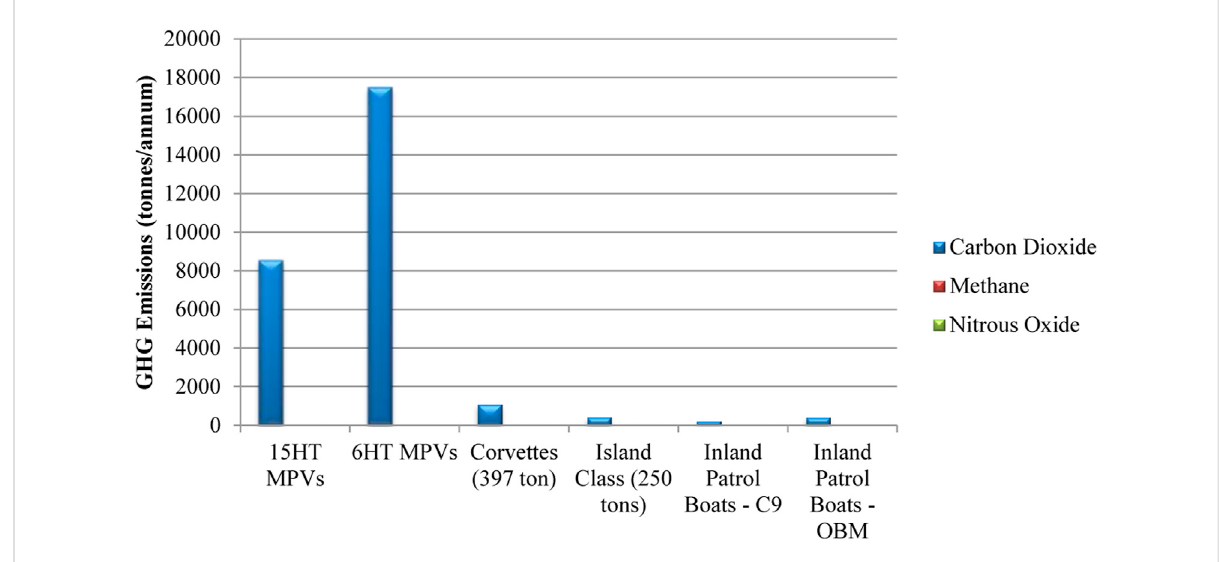
FIGURE 6 Breakdown of annual GHG emissions load from all types of PMSA vessels.